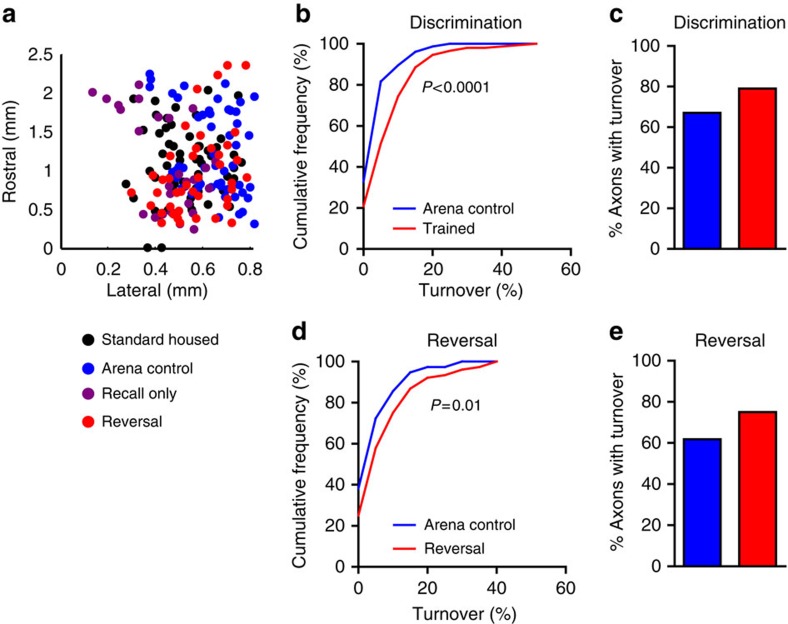
Recruitment of plasticity in the majority of axons in discrimination and reversal learning.(a) Locations of imaged axons in dmPFC. (b) Cumulative frequency histogram of the percentage of total boutons gained and lost on day 6 in ‘arena control' (n=76 axons) and odour discrimination ‘trained' (n=148 axons) mice. The distribution was shifted significantly towards higher turnover in ‘trained' group (KS statistic=0.47, P<0.0001). (c) ‘Trained' mice had more axons (79.5%) with some level of bouton turnover compared with ‘arena control' mice (67.1%). (d) On day 7, the cumulative frequency distribution of turnover was shifted towards higher turnover in the ‘reversal' group (n=76 axons) compared with ‘arena control' group (n=76 axons; KS statistic=0.25, P=0.01). (e) ‘Reversal' trained mice had more axons that gained or lost boutons (75.0%) than ‘arena control' mice (61.9%).